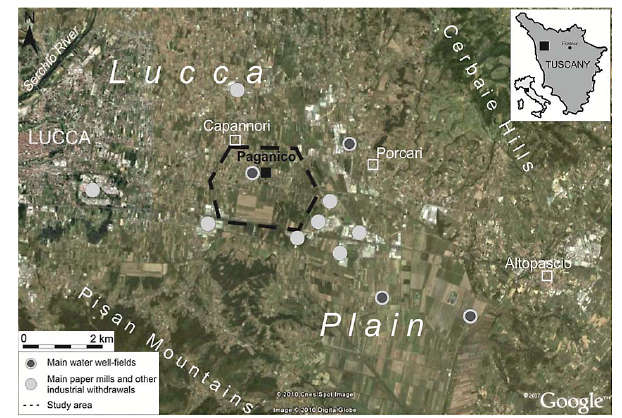
Fig. 1. Location map of the study area and main groundwater with- drawals (by